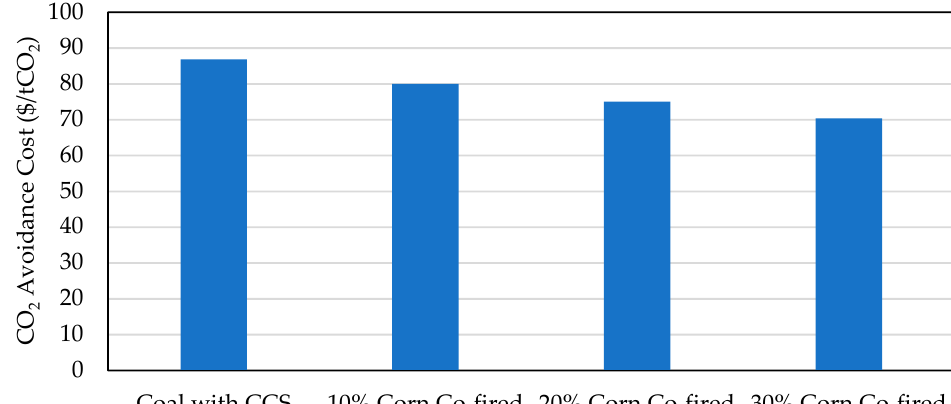
Figure 9. CAC for a 1000-MW PCC, co-fired with corn stover power plant with CCS. A PCC power plant without carbon capture and storage is used as the reference-case plant for CAC calculations.